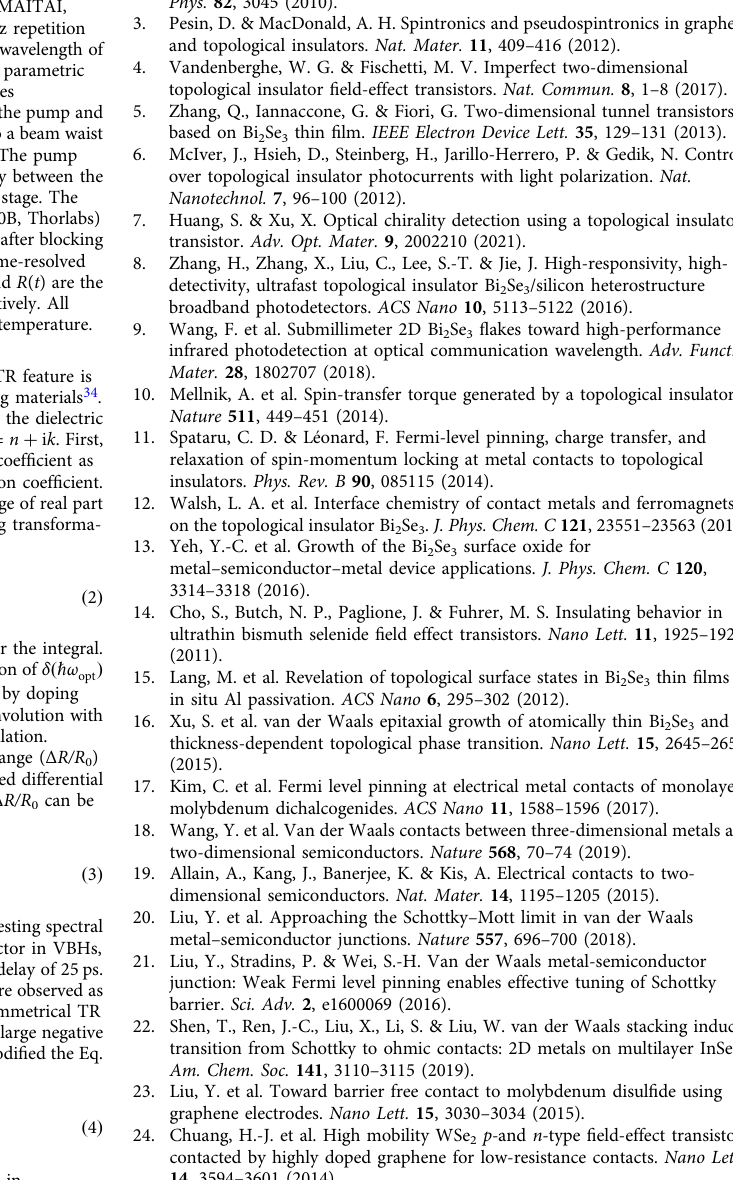
Supplementary Fig. 4c. The value of C VSe thickness and is consistent with the modi fi ed model of TR response in VBHs.